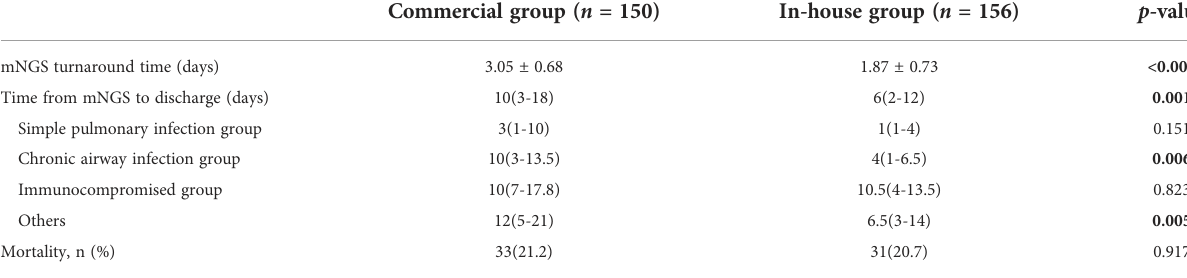
TABLE 2 Comparison of the mNGS turnaround time and the discharge time of patients. Commercial group ( n =